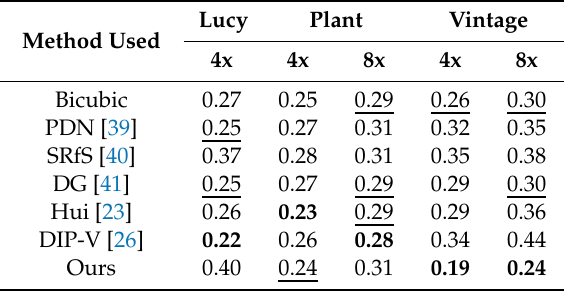
Table 4. Quantitative comparison (in RMSE) on dataset Mixture . Lucy Method Used